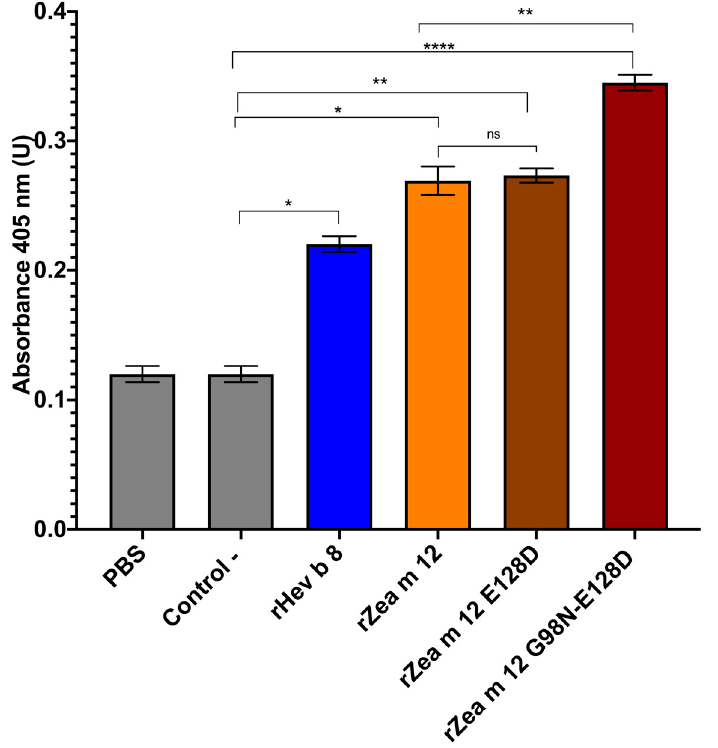
Figure 3. Specific IgE binding to rHev b 8, rZea m 12, and rZea m 12 mutants. The bars show IgE binding with the three profilins measured by indirect ELISA. The negative controls are two sera from non-allergic individuals and PBS as the background control. We used a pool of five individual sera for rZea m 12 and rZea m 12 mutants (1:5 dilution). The standard deviation of three different experiments is shown. The statistical analysis was performed by Sidak’s multiple comparisons tests (ns, not significant, p < 0.05 with one asterisk, p < 0.01 with two asterisks, and p < 0.0001 with four asterisks).